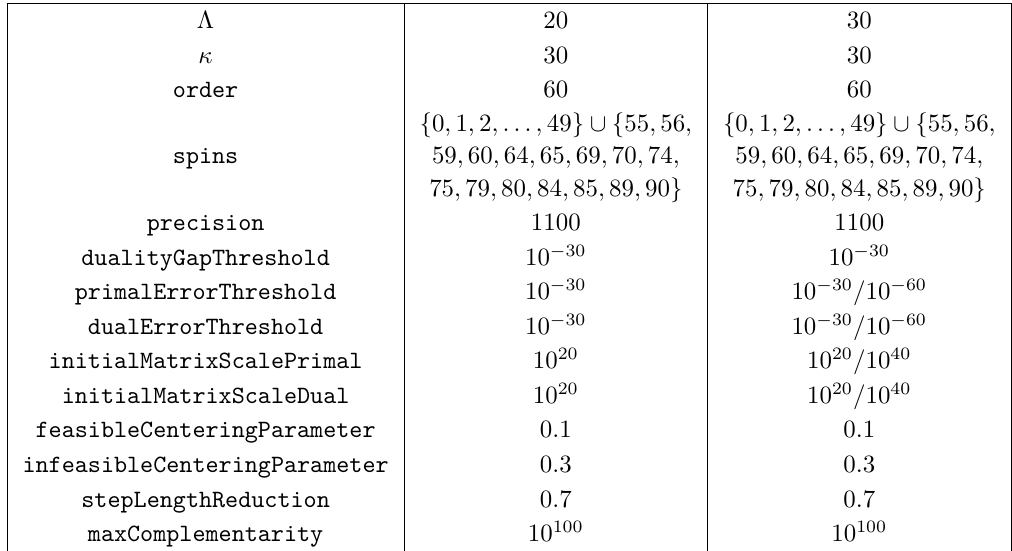
Parameters used to set up the SDPs, along with the SDPB parameters. The definition of these parameters can be found in [70]. In particular cases where we report two values, e.g 10 − 30 / 10 − 60 , this indicates that the bulk of our results were ran with the first value, however tests were performed to confirm that different values of this parameter did not change the results. In qboot we also use n = 500 . The parameters in the Λ = 20 column were used to explicitly check max that our navigator minima lie in